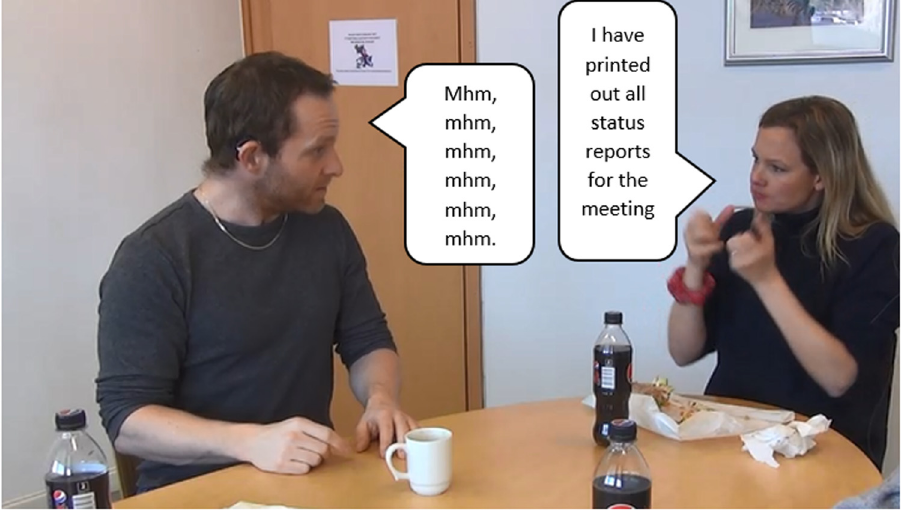
Figure 3: Slow, clear and rhythmic signing without mouthings ( right ) with sign - by - sign responsive nodding ( left ) . ( Lines 9 and 10.